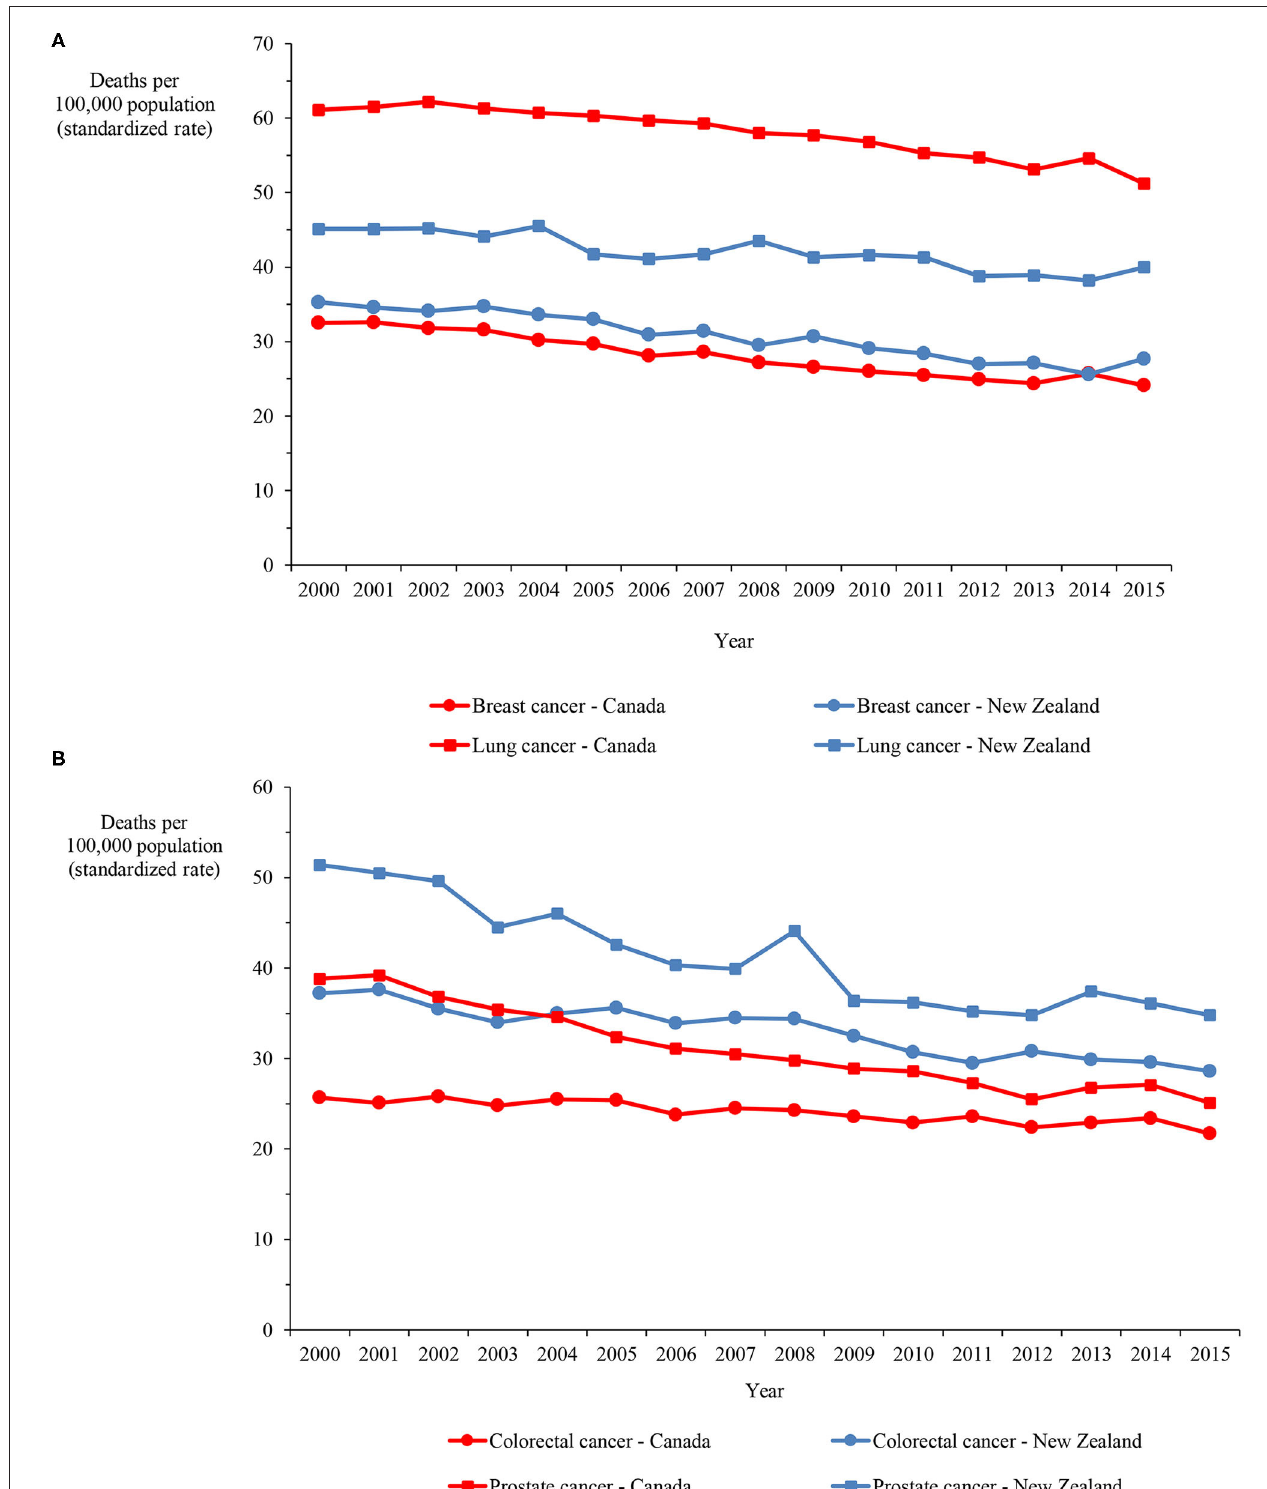
FIGURE 5 | (A) Mortality in Canada and New Zealand for breast and lung cancers, 2000–2015. (B) Mortality in Canada and New Zealand for colorectal and prostate cancers, 2000–2015.